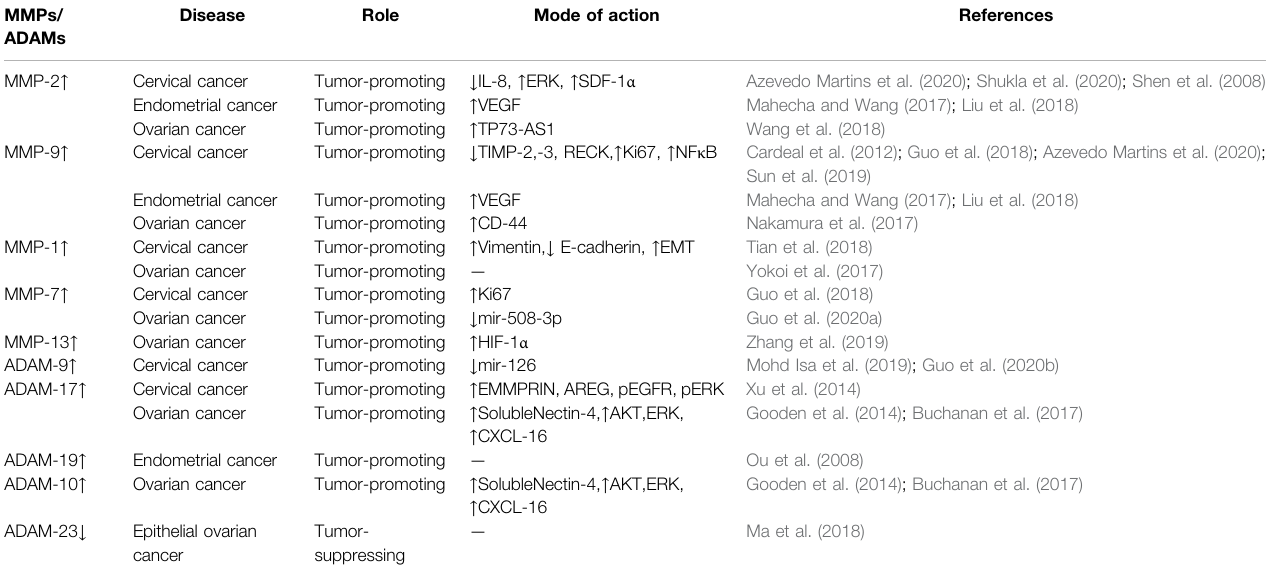
TABLE 1 | Involvement of metalloproteinases in the regulation of gynecological malignancies. MMPs/